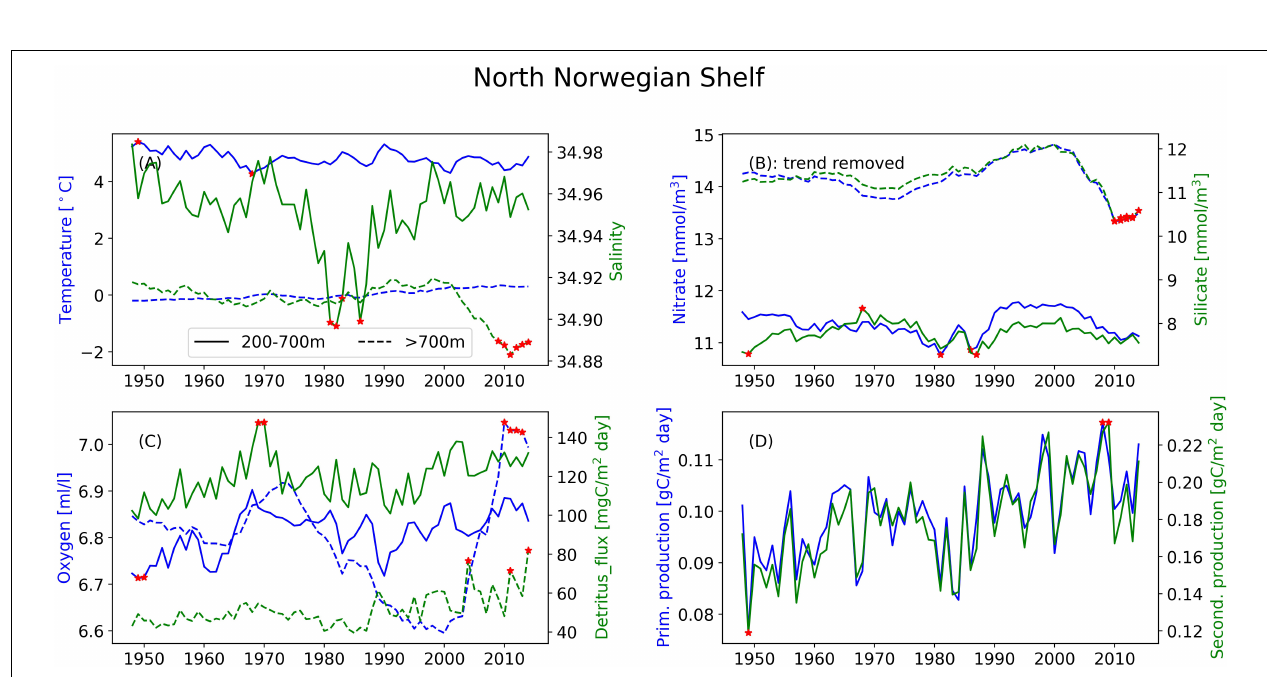
FIGURE 6 | Timeseries of the annual mean of different variables illustrating the interannual variability at the North Norwegian Shelf for (A) temperature (blue) and salinity (green), (B) nitrate (blue) and silicate (green), and (C) oxygen (blue) and detritus (green). Solid lines are areas with bottom depth between 200 and 700 m, dashed lines are areas deeper than 700 m. (D) Depth-integrated primary production (blue) and secondary production (green) from the full area. Red stars indicate years when values are outside two standard deviations of the temporal mean.